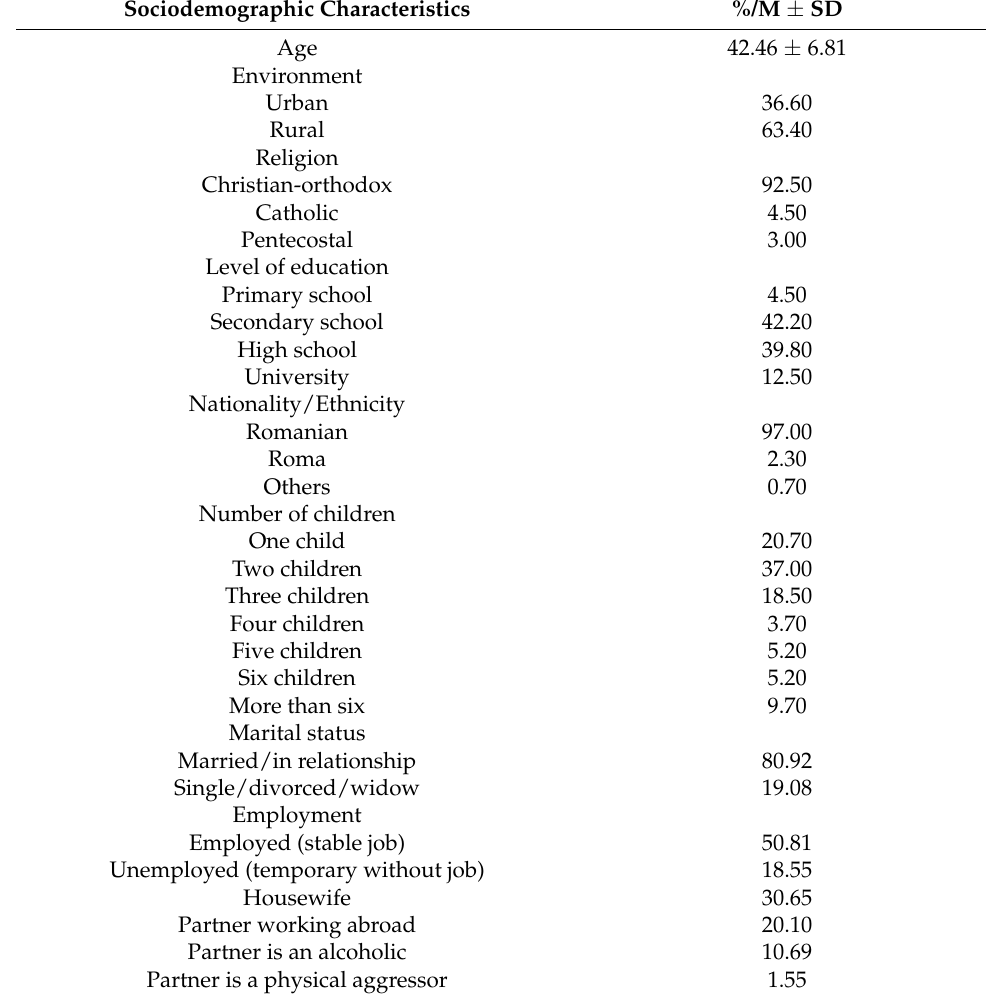
Table 1. Sociodemographic characteristics 1